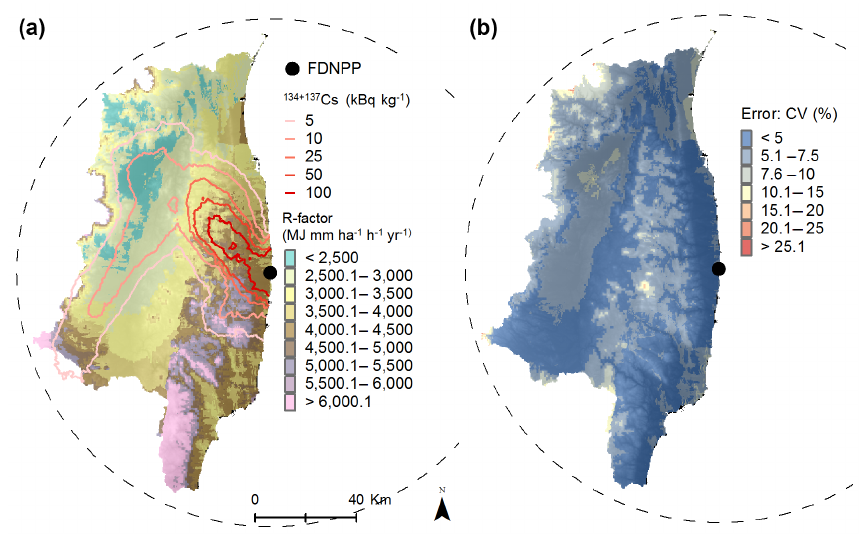
Figure 7. Annual R factor (a) and model errors depicted as the coefficient of variation (i.e. CV = (standard error/mean) · 100) (b) for catch- ments entirely contained within a 100km radius of the FDNPP. 134 + 137 Cs activities are from Chartin et al.